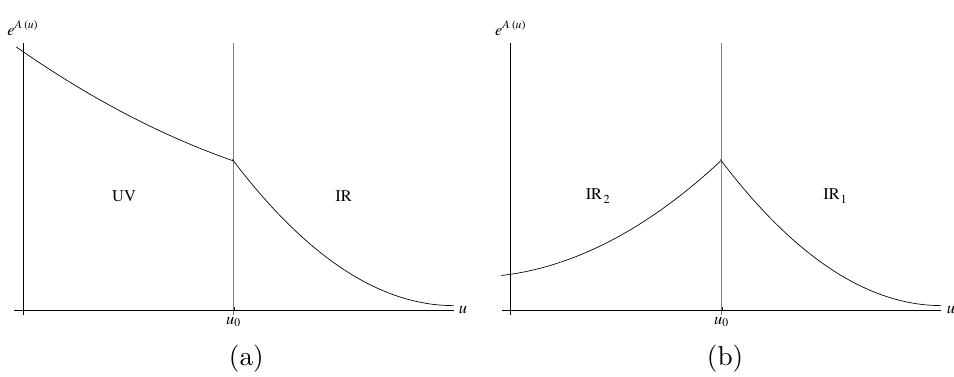
Figure 3 . The behavior of the scale factor e A as a function of the holographic coordinate u , in the two cases W UV > 0 (left) and W UV < 0 (right). (a) In case A , the junction connects an IR and a UV region. (b) In case B , the junction is a maximum of the scale factor and connects two IR